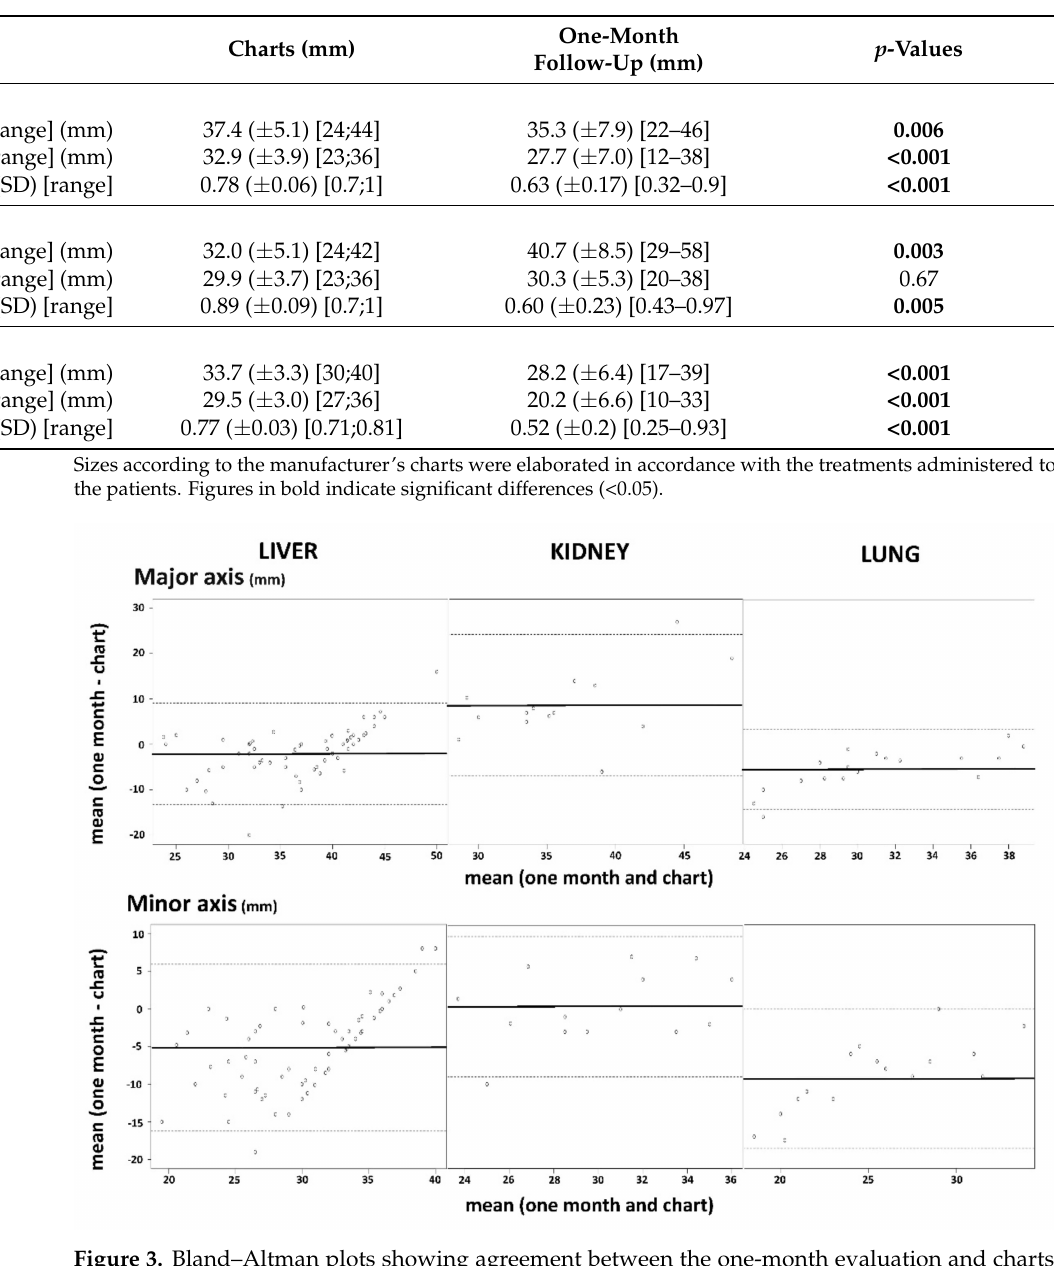
Table 3. Ablation zones sizes and sphericity index expected according to the manufacturer’s charts and measured on the one-month follow-up.